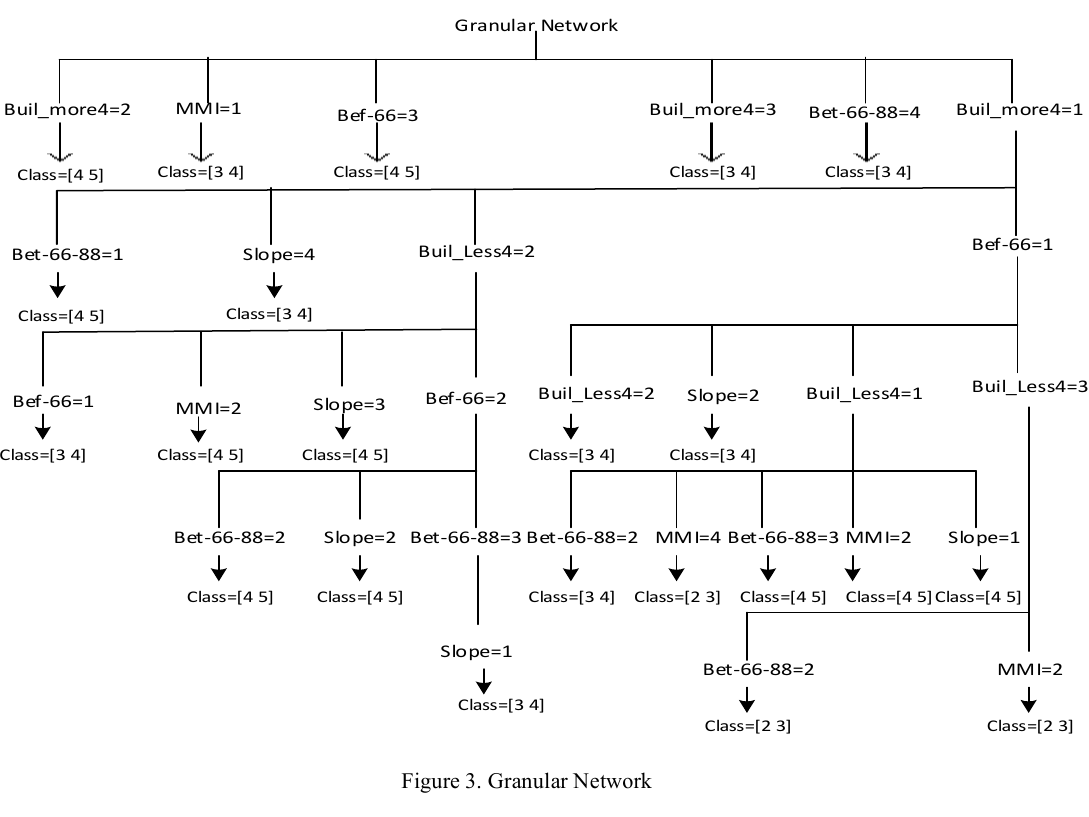
Figure 3. Granular